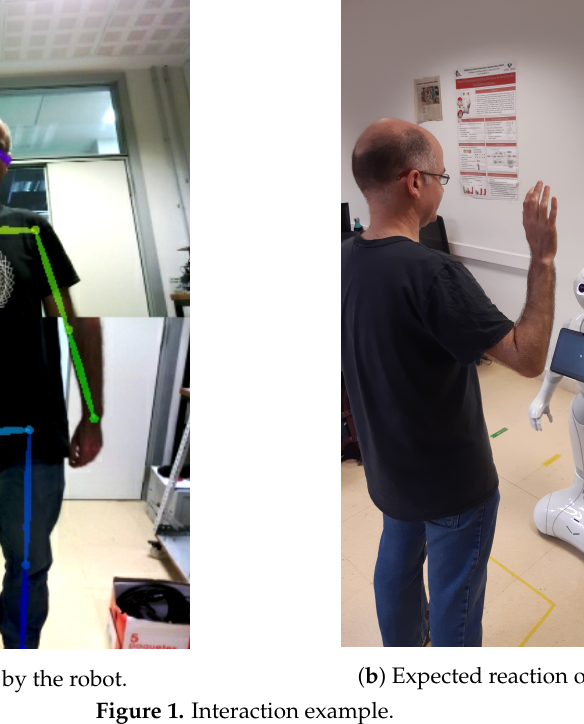
Figure 1. Interaction example.